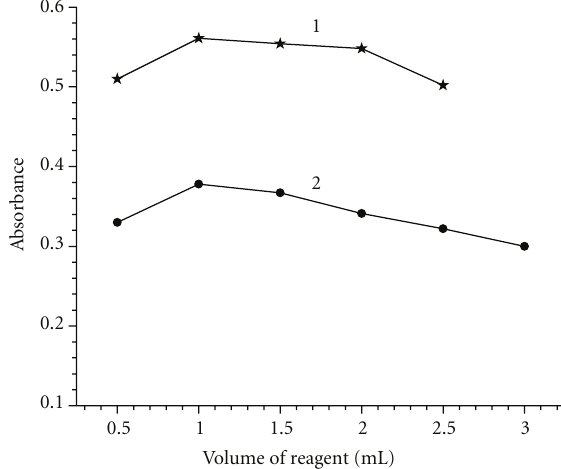
Figure 2: E ff ect of reagents concentration on color development: (1) p-CA (0.5%) using 200 μ g mL − 1 MPM, and (2) DDQ (0.25%) using 40 μ g mL − 1